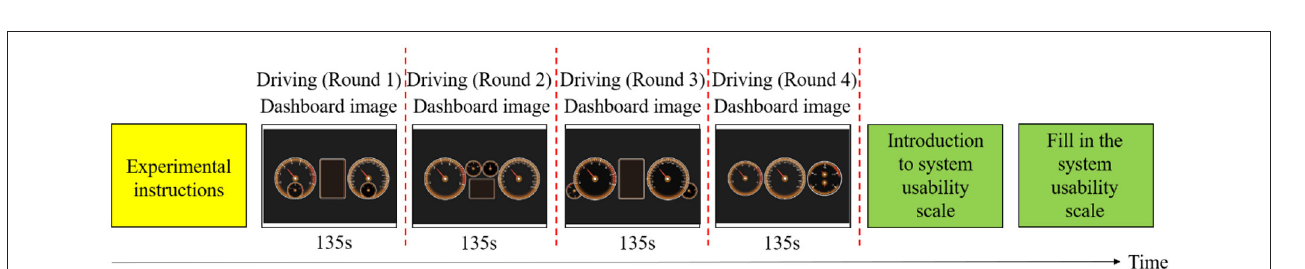
FIGURE 2 | The stimuli of the experiment: (A–D) four types of dashboard layouts.